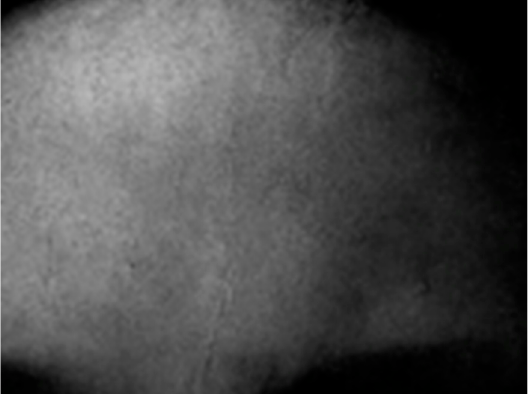
Figure 6. The date 1489 is visible across the forehead of the controversial Salvator Mundi. This autographic marker might indicate that the work is a genuine Leonardo. The